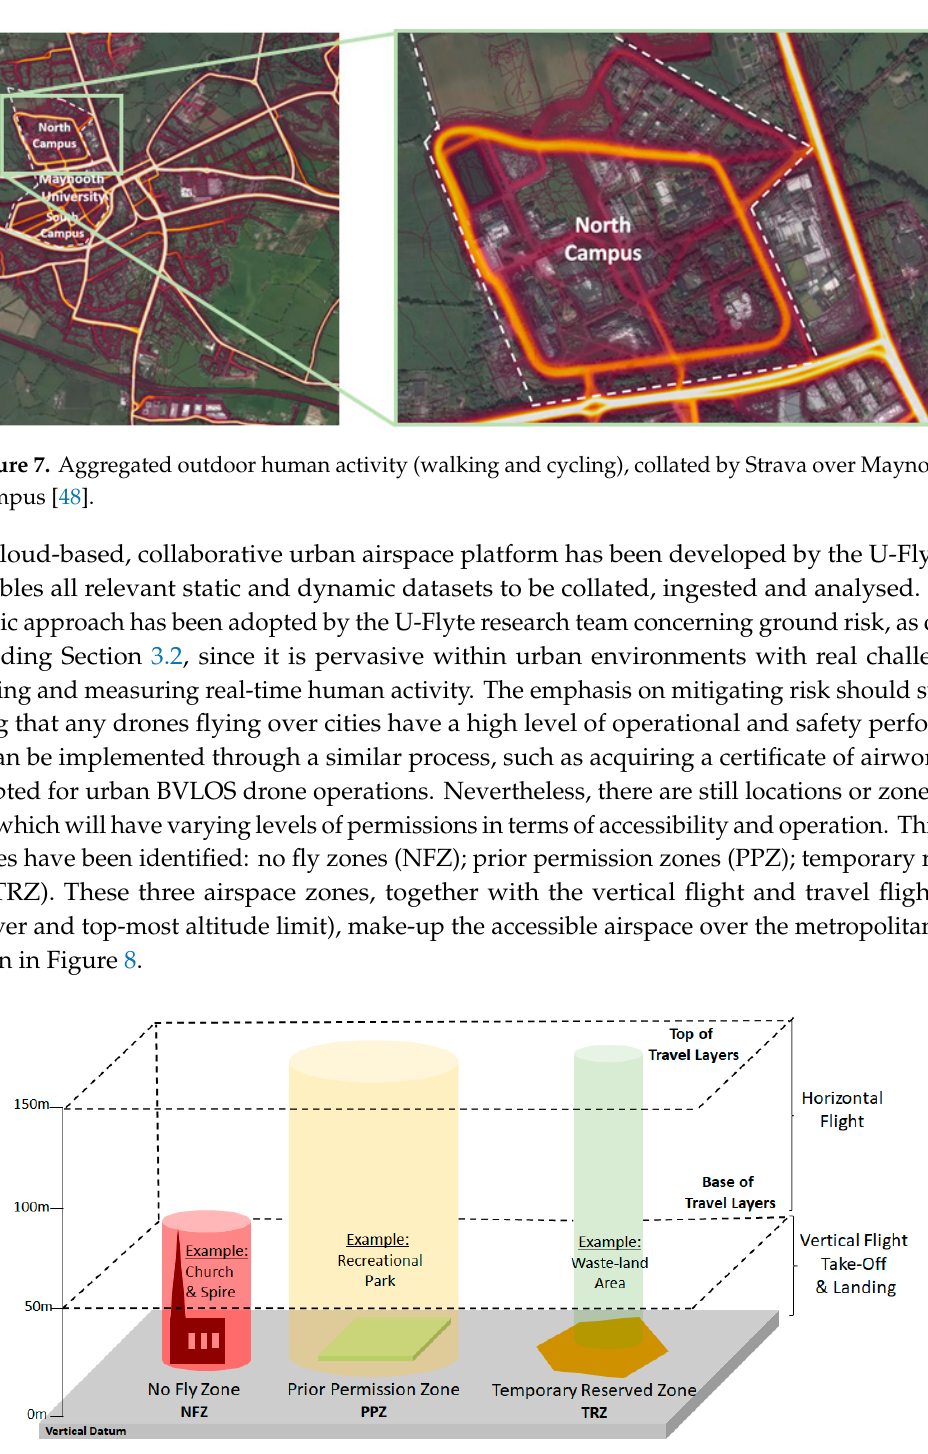
(b) Figure 6. ( a ) Maynooth urban area classified into various high-level land-use types; ( b ) residential sub-classes. One relatively new data layer that will play an increasingly important role in urban UTM is near real-time human activity. Although demographical data, such as census datasets, are useful, these